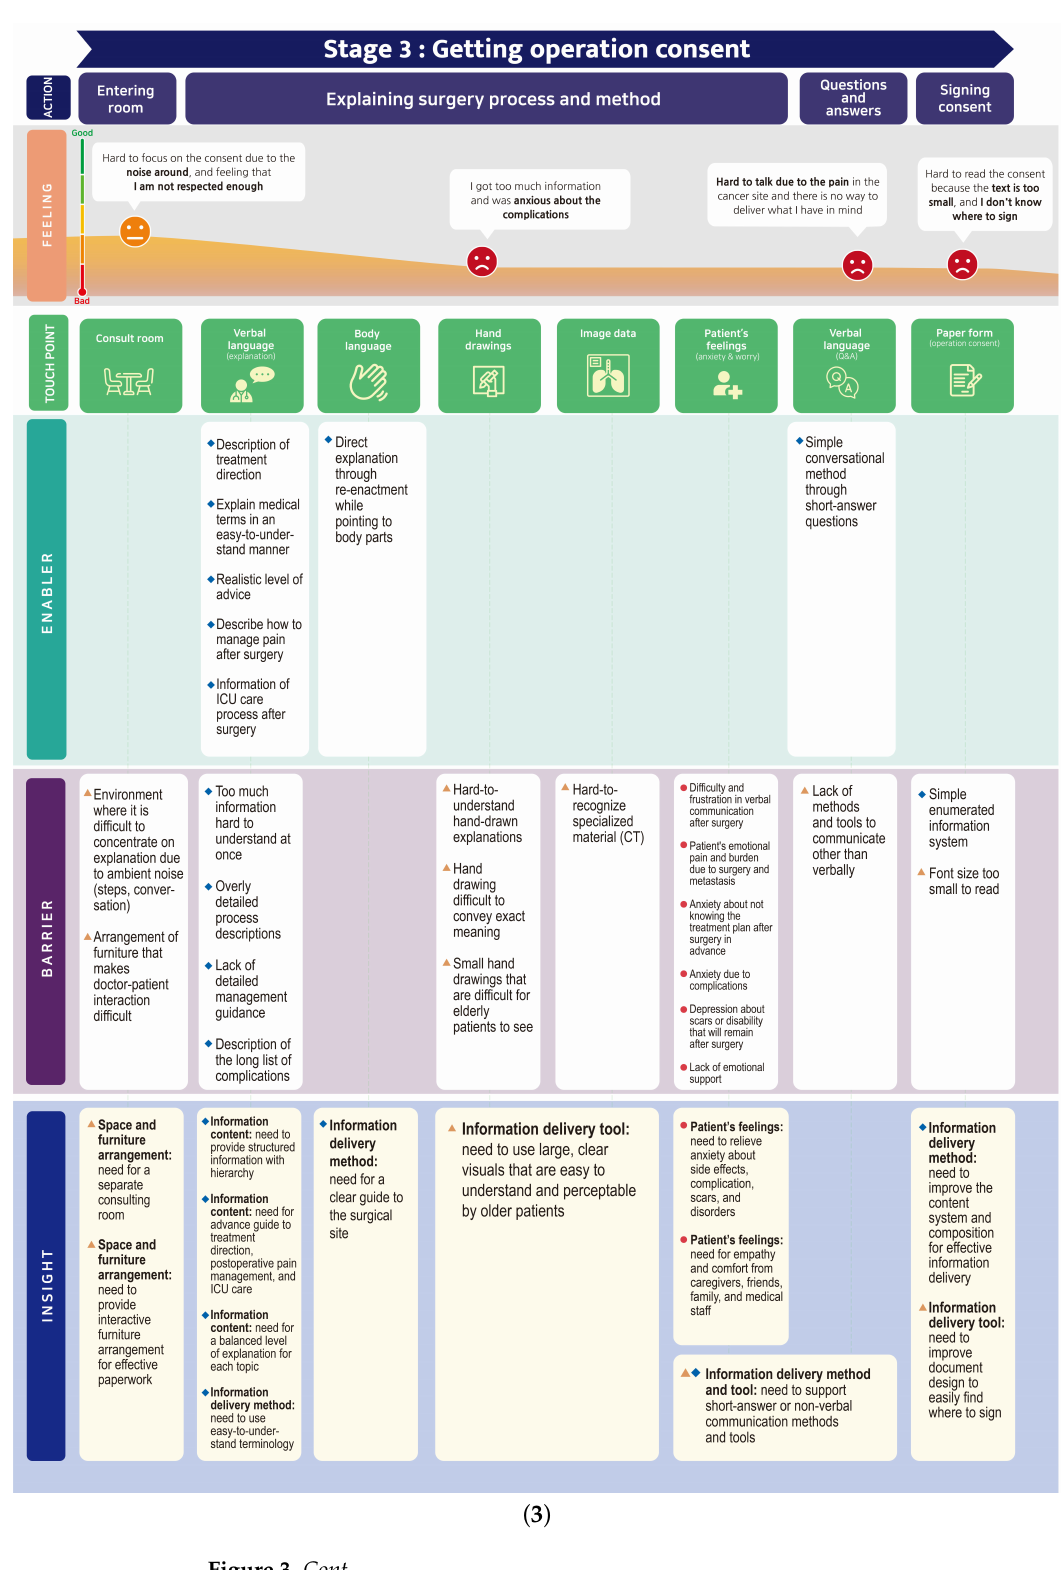
Figure 4. This is a wide figure. Figure 3. Cont